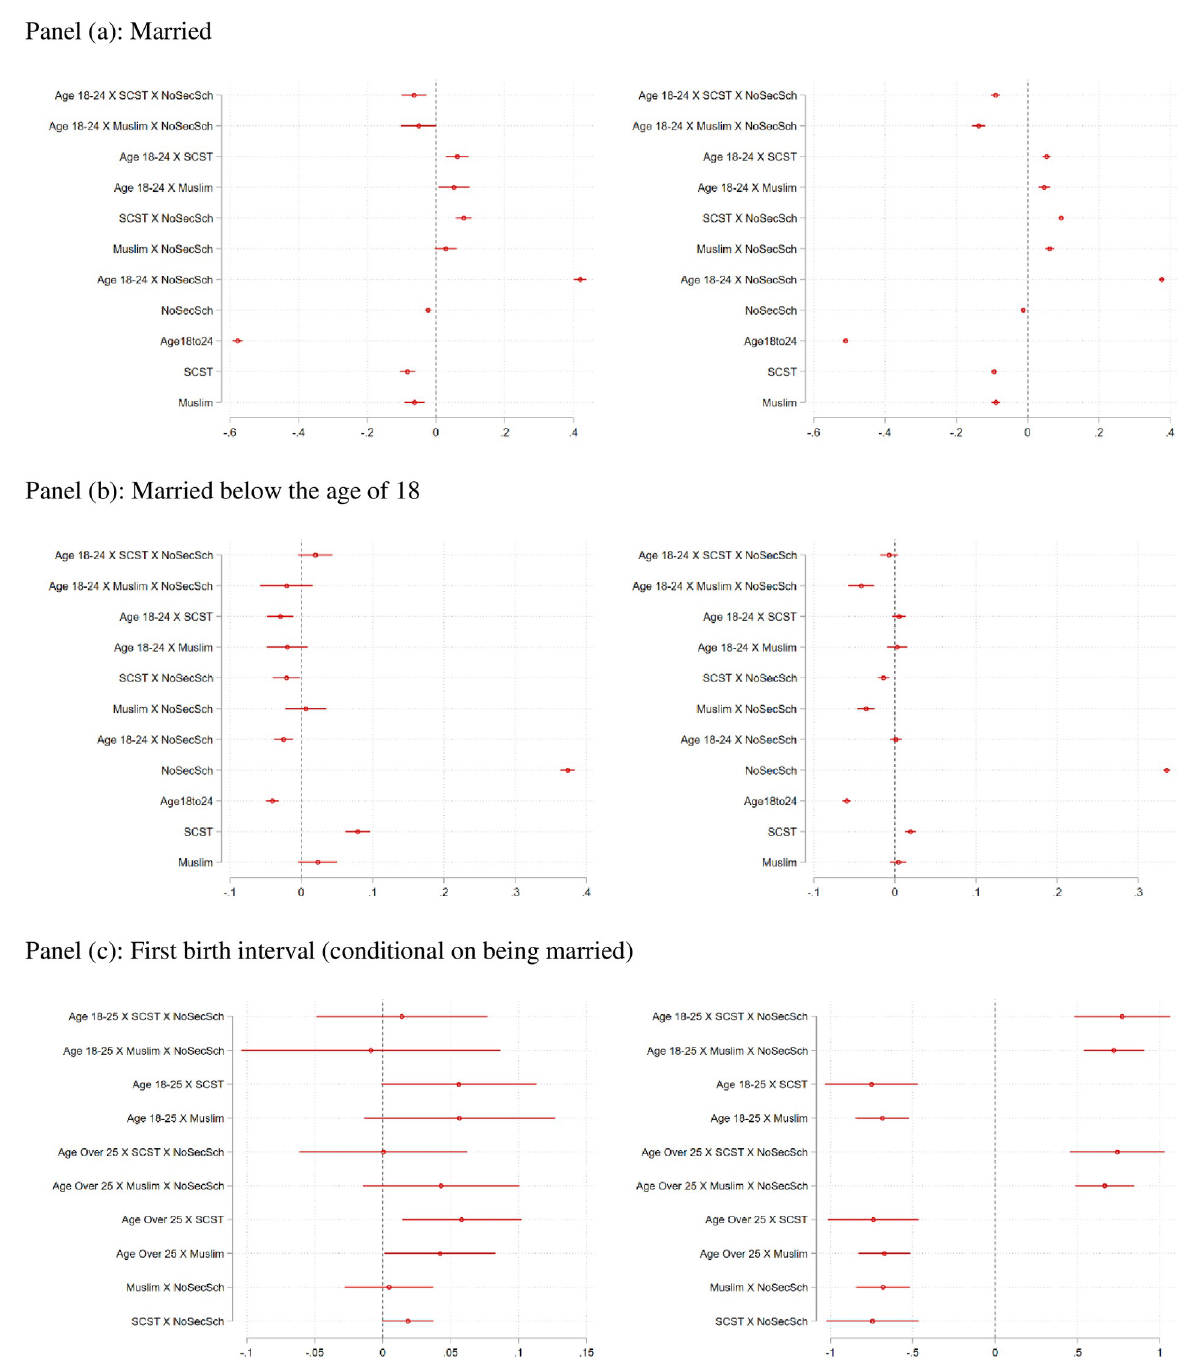
Fig 7. Coefficients, with confidence intervals, for regressions of key outcomes: The dummy variable for marriage below the age of 18 (dependent variable, measured in months), age at first birth, and the first birth interval on age intervals as well as a set of control variables that include schooling (as measured by completion of secondary school), dummies for religious groups, dummies for caste groups and state-level fixed-effects. The left panel depicts estimates for the regressions with the sample from Round 3 (2005–06) and the right panel shows the estimates from round 4 (2015–16). The excluded group in all regressions is the group above than the age of 40.